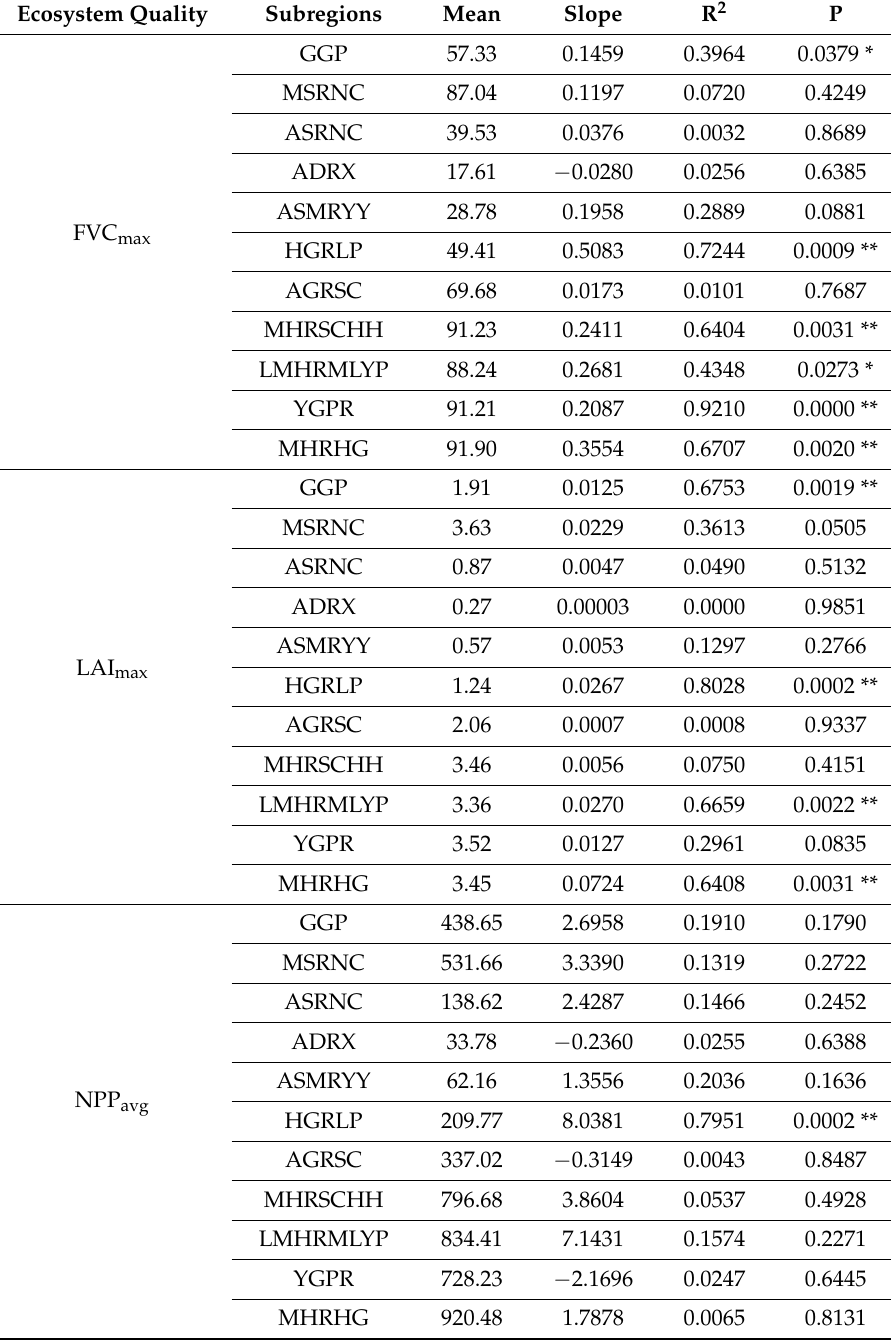
Table 5. Statistical parameter values of ecosystem quality indicators in the Grain for Green Program (GGP) area from 2000 to 2010. The units of the mean and slope of FVC max are % and % yr − 1 ,